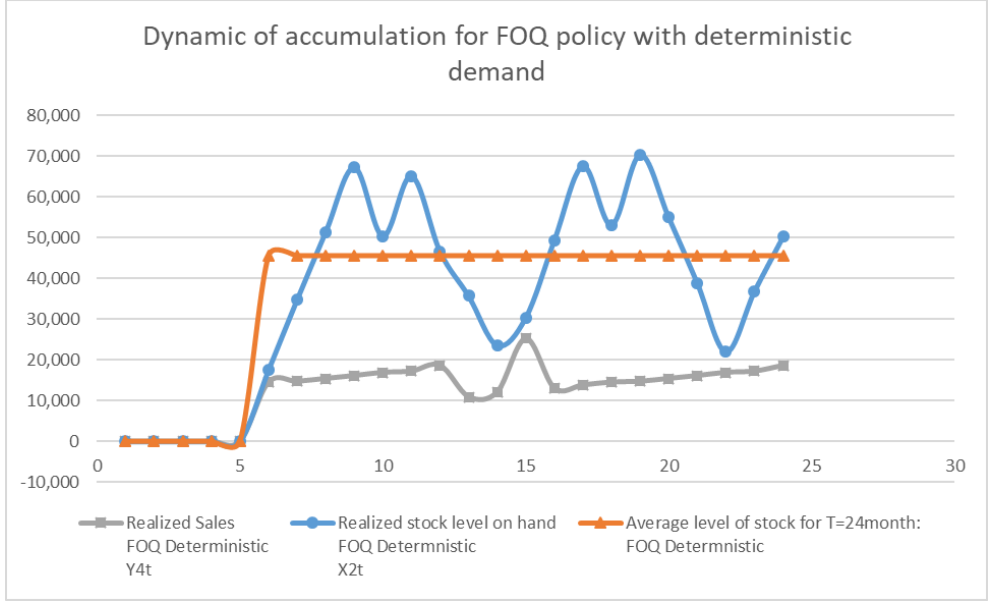
Figure 7. Dynamic of accumulation for Case 1: FOQ policy with deterministic demand.